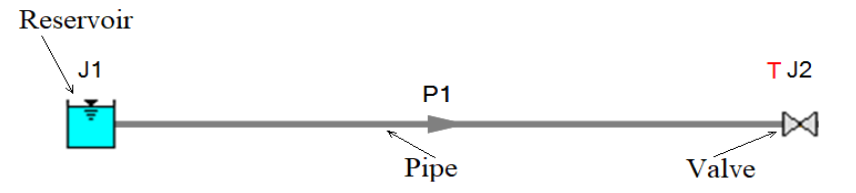
Figure 2. The generalized layout for